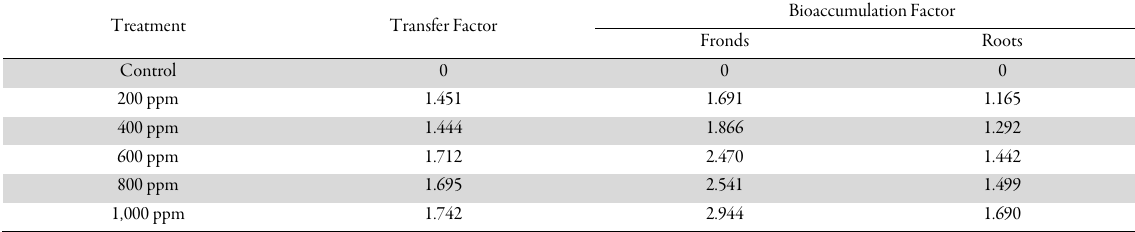
Table 3. Lead bioaccumulation and transfer factors in Pteris vittata after growing for 12 weeks in lead contaminated soils Treatment